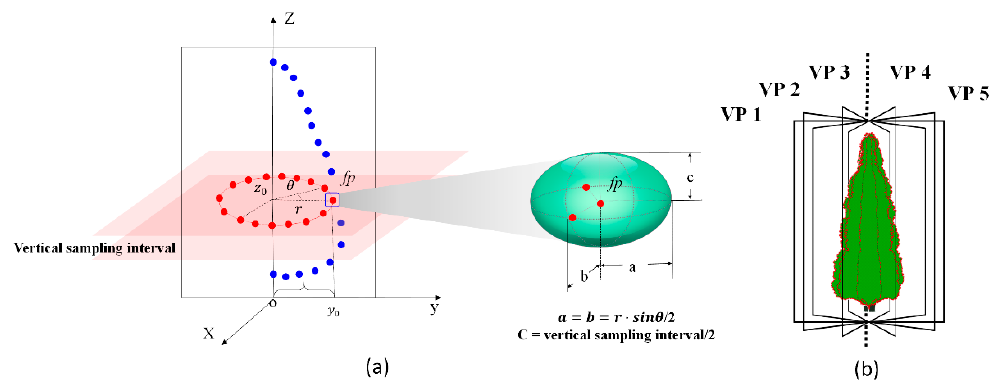
Figure 8. Creating a sphere-like surface to represent a tree crown: ( a ) rotating and disturbing the feature points of the tree profile acquired from a single tree image, blue points denote feature points extracted from silhouette and red points denote the points created by rotation from one feature point; ( b ) geometric outlines of the tree crown created from multiple images taken from different viewpoints.